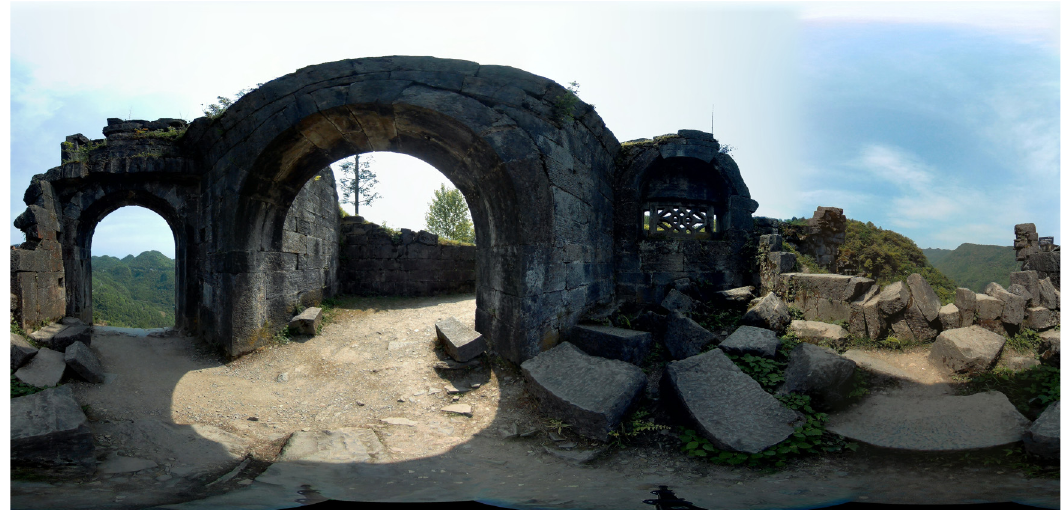
Figure 3: Panorama of Feilong Pass after image